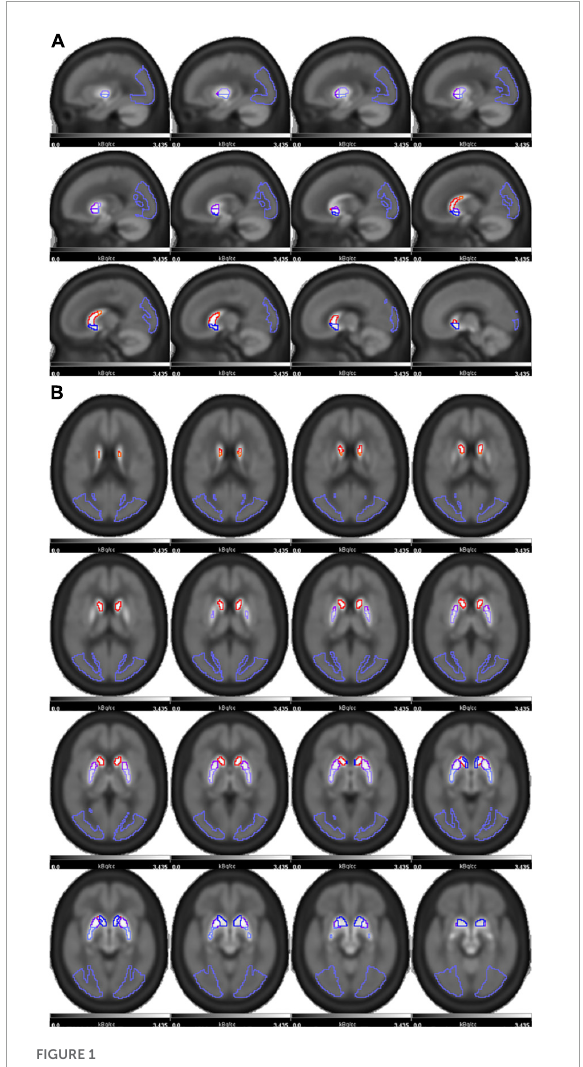
FIGURE1 The 18 F-FP-DTBZ PET image template with striatum regions was superimposed and shown in sagittal (A) and axial (B) positions. The striatum of each side was divided into five subregions as follows: caudate(red), anterior dorsal putamen (ADP, purple), anterior ventral putamen (AVP, dark purple), posterior dorsal putamen (PDP, pale purple), posterior ventral putamen (PVP, blue). The occipital lobe(violet) was used as the reference region.